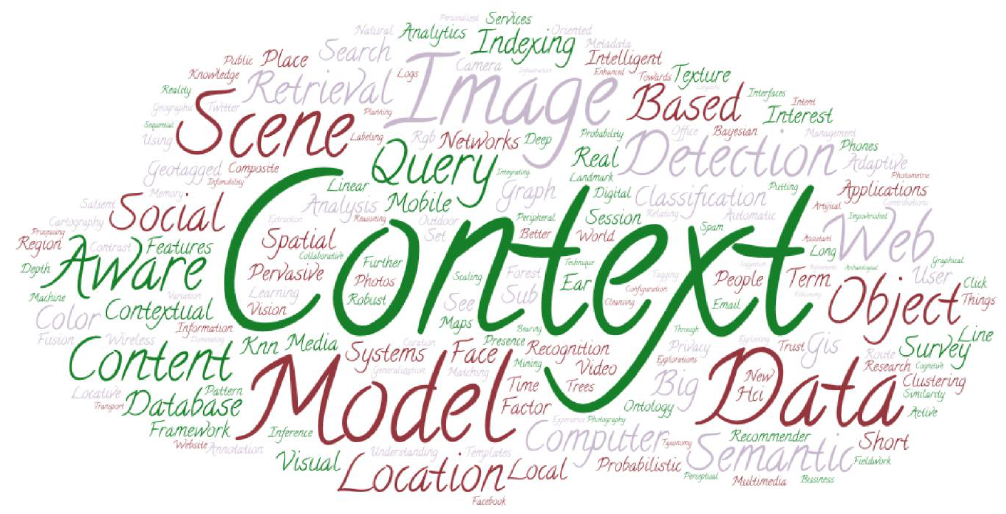
Figure 1. Word cloud produced by the 187 unique keywords of the 50 herein discussed papers (Created with https://wordart.com/create/ public web service).